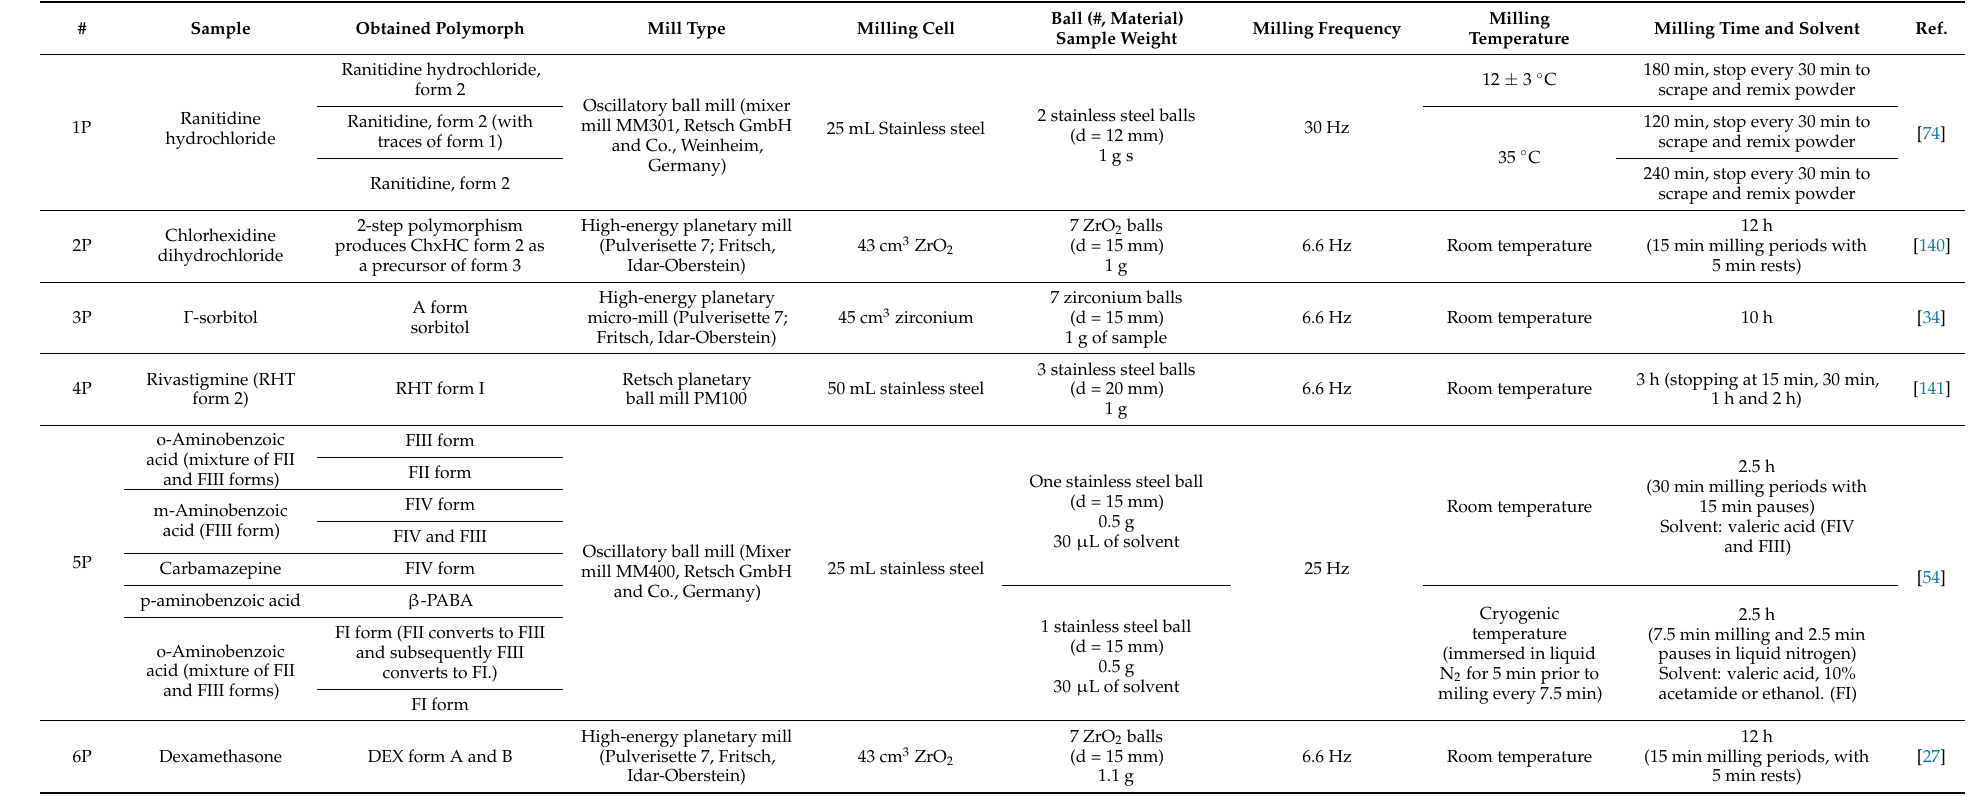
Table 3. Conditions of preparation of polymorphs by mechanical